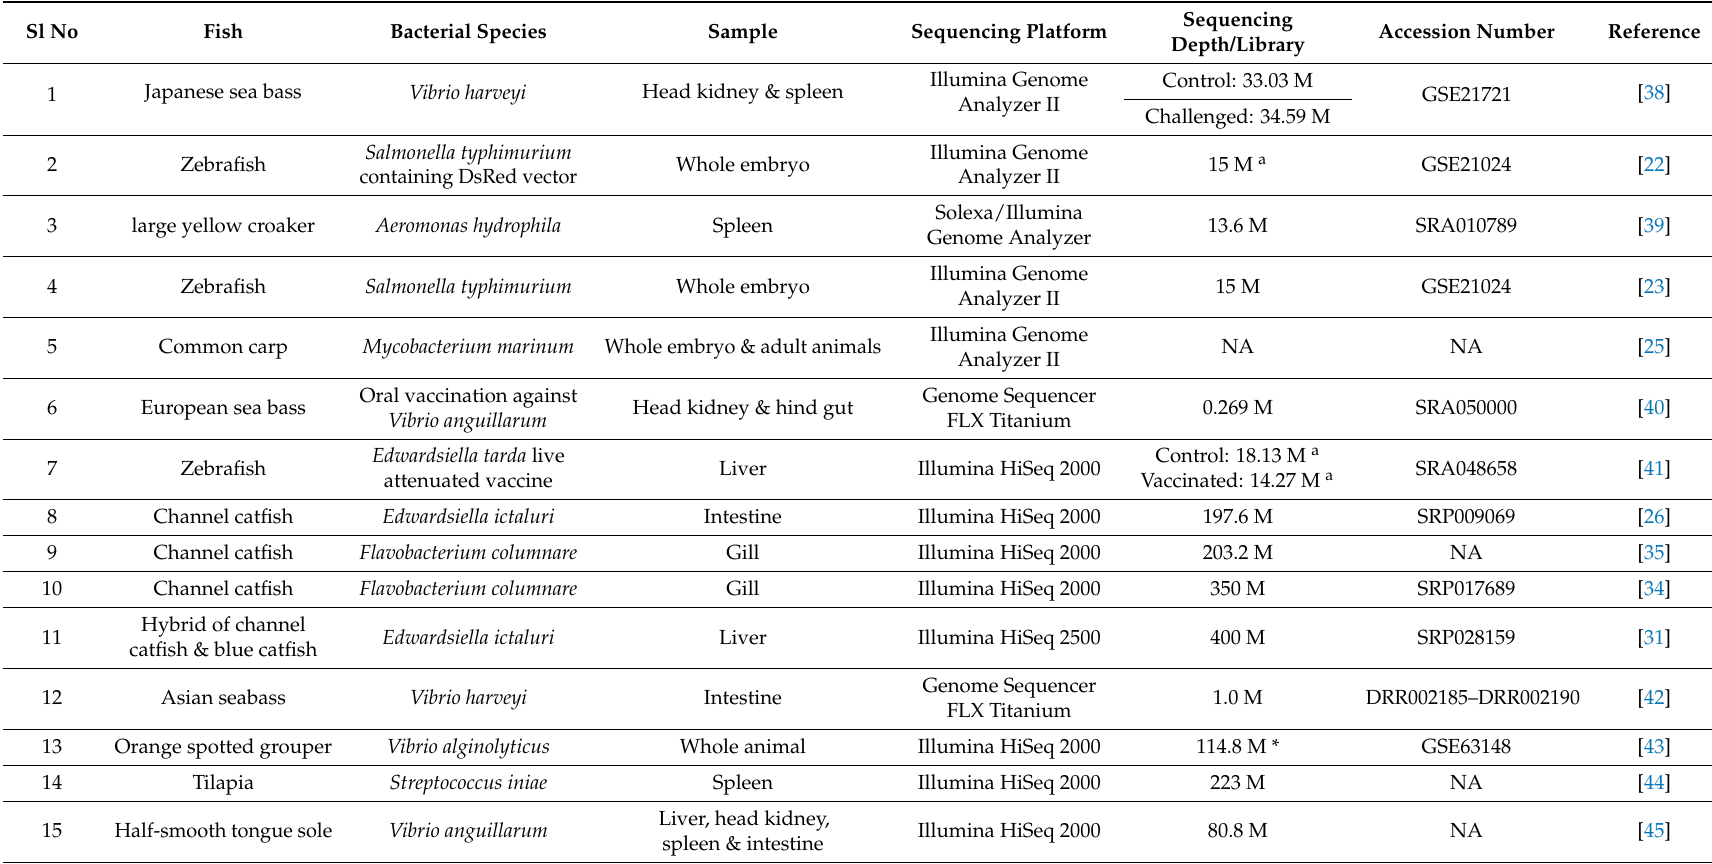
Table 1. RNA-Seq analysis of fish in response to bacterial pathogens. This table shows a description of the transcriptomes to understand bacterial diseases in various fish